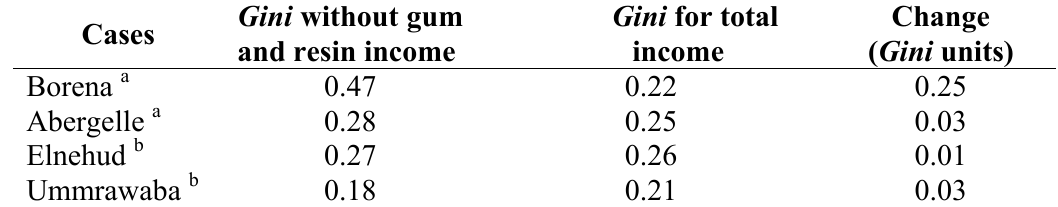
Table 5. Gini coefficient with and without gum and resin income in the four case study areas,